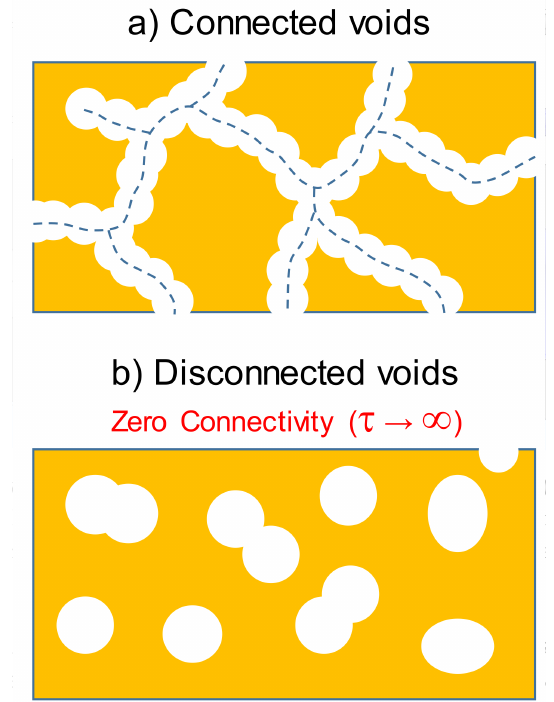
Figure 1. Sketch of two different structure morphologies: ( a ) Interconnected voids (with a certain value of tortuosity) and ( b ) Completely disconnected voids (zero connectivity and infinite